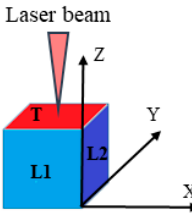
Figure 1. Cubic specimen sections with orientations of T, L1, and L2 with respect to the laser beam.